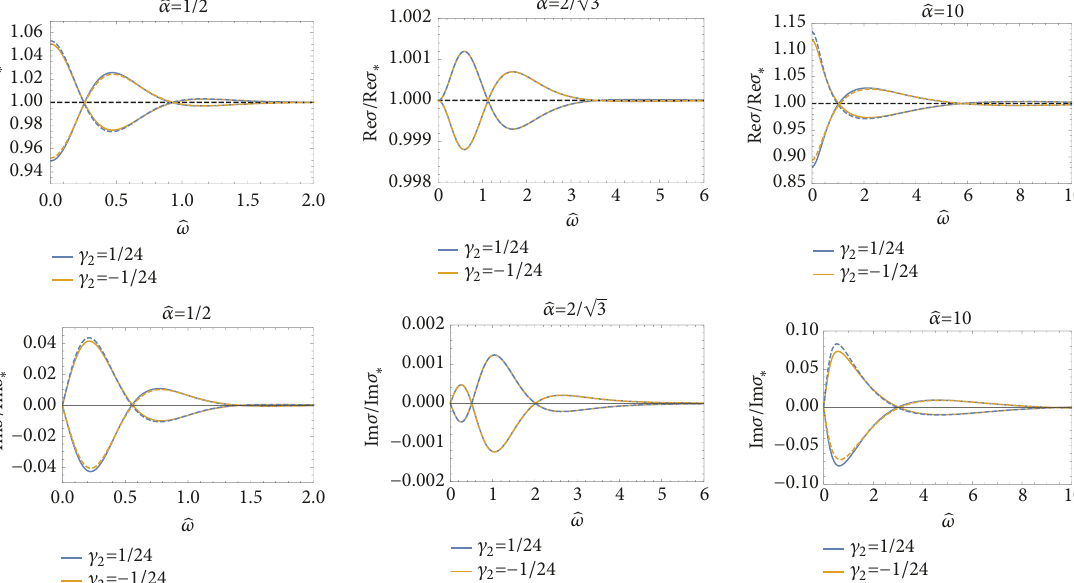
Figure 22:The real part (theplot above)and the imaginary part(the plot below)of theoptical conductivityas the functionof ̂𝜔 for |𝛾 2 | = 1/24 and various values of ̂𝛼 . The solid curves are the conductivity 𝜎 of the original EM theory (4) and the dashed curves display the conductivity 𝜎 ∗ of the EM dual theory